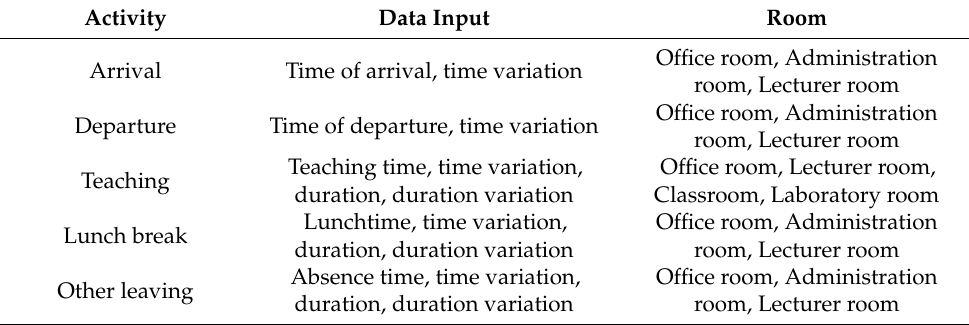
Table 2. Data input of the presence